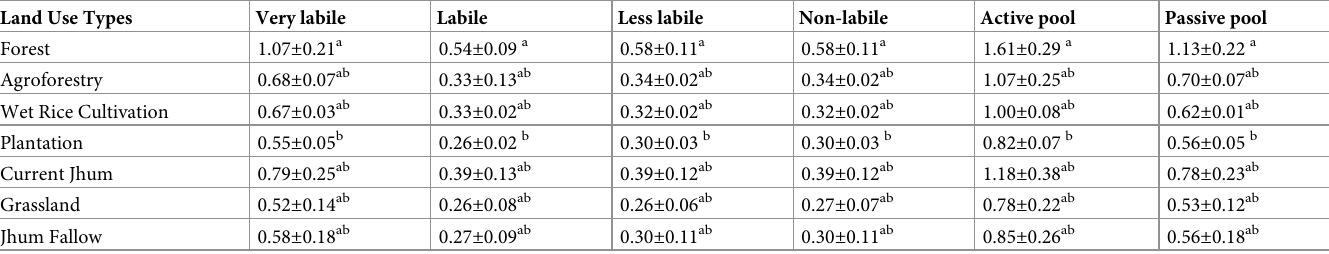
Table 4. Soil organic carbon concentration (%) of varying lability at in different land use types (0–45 cm soil depth) of Mizoram.